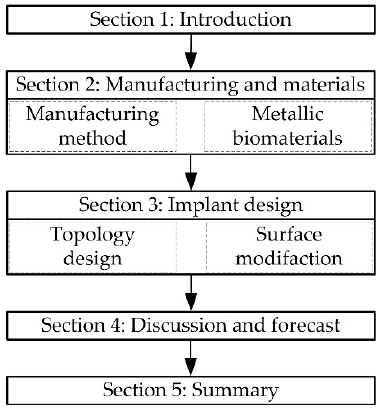
Figure 1. The structure of this review. 2. Additive Manufacturing Metallic Implants